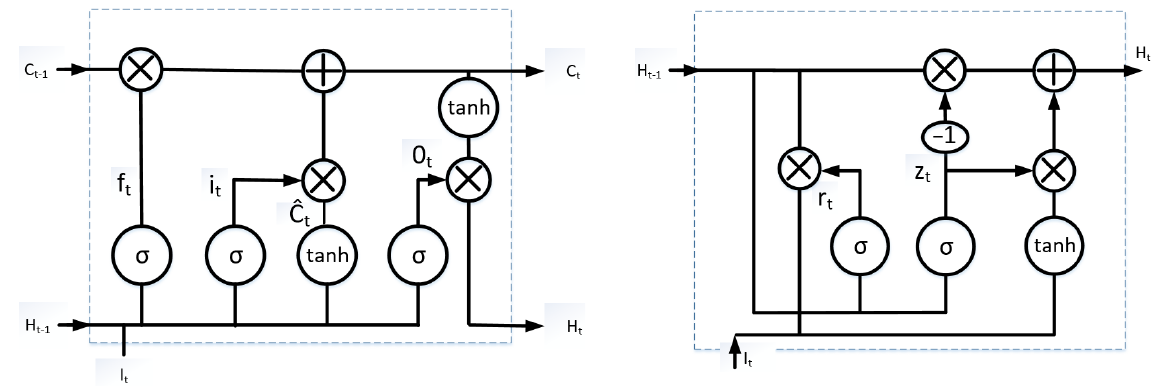
Figure 4. LSTM and GRU unit.